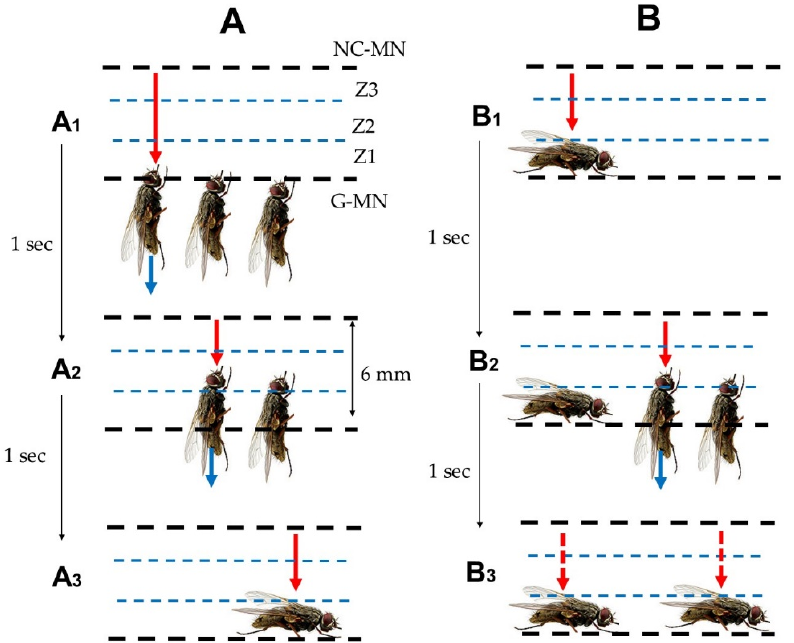
Figure 8. Schematic representation of the standby and follow-up arcing to multiple houseflies that entered the arcing zone of the arc-discharge exposer (ADE) simultaneously. ( A ) Simultaneous entry to the first arcing zone (Z1) by three houseflies. The housefly on the left, which was nearest to the negatively charged metal net (NC-MN), was the first to be subjected to arc discharge from the NC-MN and thrown down (A1). The other flies moved into Zone 2 (Z2) for 1 sec, and a second fly was subjected to the arcing (A2). Before the third arcing, the last fly climbed over the grounded metal net (G-MN) and was subjected to arc discharge (A3). ( B ) Simultaneous entry by two houseflies to the arcing zone in which the first fly had been present. The housefly that remained in the electric field was subjected to a pulsed arc-discharge exposure (B1) continuously until the next fly entered and moved close to the NC-MN. Of the two flies that entered the arcing zone simultaneously, the one that was closest to the NC-MN was subjected to the arcing and thrown down (B2). The second fly was subjected to arcing only after it had climbed over the G-MN (B3). The solid red arrow represents arcing to the fly from the NC-MN. The dotted red arrow represents selective arcing to one of the two flies, i.e., whichever fly was closest to the NC ‐ MN at the moment of arcing. The blue arrow represents the pathway taken as the fly falls.